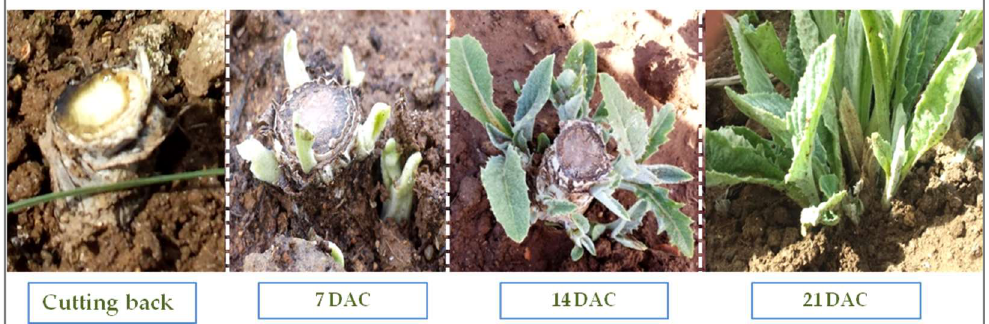
Figure 4. Chronology of offshoot emission from nursery plants of treatment T4 after cutting back and after 7, 14, 21 days after cut-back (DAC).